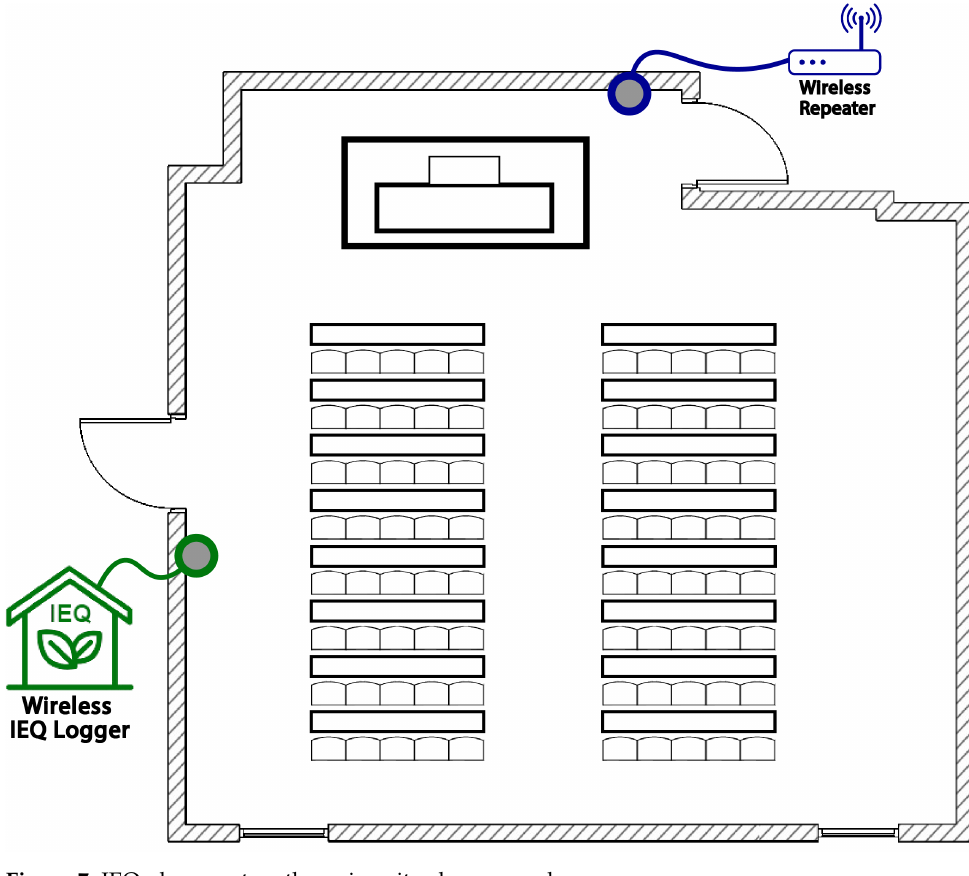
Figure 7. IEQ placement on the university classroom plan.